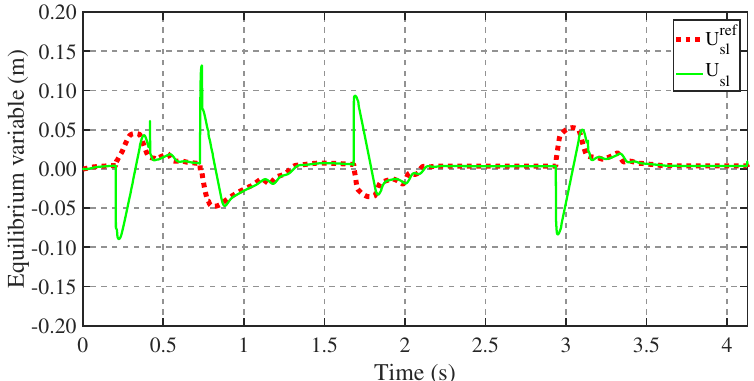
Figure 7. Trajectory of the equilibrium variable when the robot slides on uneven terrain. Figure 8 shows the trajectory of the postural stability criterion. The tracking error of U sl will increase when the slope angle changes. Therefore, the control state of the system will deviate from the dual-objective convergence state and the posture stability criterion will diverge. The maximum deviation amplitude of the postural stability criterion in the sliding process is 2.1 Kg · m 2 /s. At t = 2.2 to 2.9 s and at t = 3.6 s to the moment of that the robot stops, E sl maintains an offset of − 0.38 kg · m 2 /s and 0.27 kg · m 2 /s, respectively. This is because the robot is in the torso recovery state, where the robot recovers its torso posture while maintaining the equilibrium position.